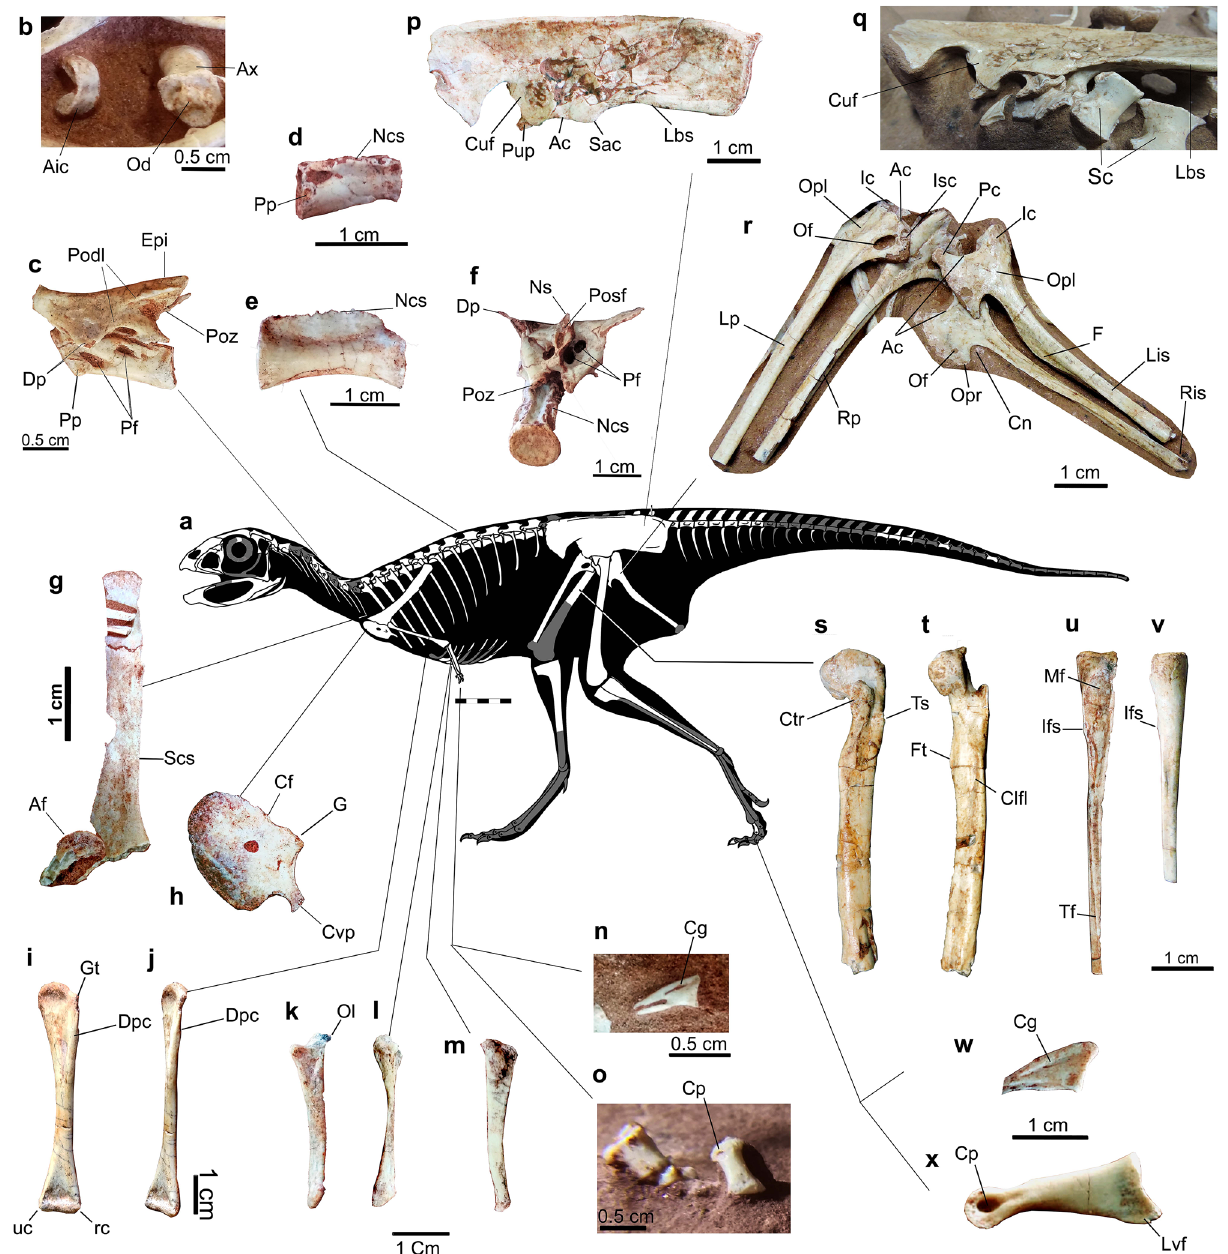
Figure 5. Interpretative line drawing of Berthasaura leopoldinae gen. et sp. nov . , holotype (MN 7821-V), and photographs. ( a ) Line drawing reconstruction; ( b ) Intercetrum and axis in cranioventral views; ( c ) 4th cervical vertebrae in lateral view; ( d ) First trunk centrum in lateral view; ( e ) 8th trunk centrum in lateral view; ( f ) last sacral vertebrae in caudal view; ( g ) right scapula in medial view; ( h ) left coracoid in lateral view; ( i , j ) left humerus in cranial and lateral views, respectively; ( k , l ) left ulna in lateral and cranial views, respectively; ( m ) left radius in cranial view; ( n ) manual ungual in lateral view; ( o ) manual phalanges II (in dorsal view) and III (in lateral view); ( p ) left ilium in lateral view; ( q ) left ilium in ventral view; ( r ) pubes and ischia; ( s , t ) left femur in cranial and medial views, respectively; ( u ) left fibula in medial view; ( v ) right fibula in lateral view; ( w ) pedal ungual in lateral view; ( x ) left pedal phalanx III-1 in lateral view. Abbreviations: Ac, Acetabular margin; Af, Acromion fragment; Aic, Axial intercentrum; Cf, Coracoid foramen; Cg, Colateral vascular groove; Clfl, Fossa for attachment of M. Caudofemoralis longus ; Cn, Caudal notch; Cp, Colateral pit; Ctr, Cranial trochanter; Cuf, Cuppedicus fossa; Cvp, Caudoventral process; Dp, Diapophysis; Dpc, Deltopectoral crest; Epi, Epipophysis; F, Flange; Ft, Fourth trochanter; G, Glenoid; Gt, Greater trochanter; Ic, Iliac contact; Ifs, scar for M. iliofibularis ; Isc, Ischial contact; Lbs, Lateral brevis shelf; Lis, Left ischium; Lp, Left pubis; Lvf, Lateroventral flange; Mf, Medial fossa; Clfl, Fossa for M. caudofemoralis longus ; Ncs, Neurocentral suture; Ns, Neural spine; Od, Odontoid process; Ax, Axial centrum; Of, Obturator foramen; Ol, Oleacron; Opl, Obturator plate; Opr, Obturator process; Pc, Pubic contact; Pf, Pneumatic foramina; Podl, Postzygodiapophyseal lamina; Posf, Post spinal fossa; Poz, Postzygapophysis; Pp, Parapophysis; Pup, Pubic peduncle; Rc, Radial condyle; Ris, Right ischium; Rp, Right pubis; Sac, Supraacetabular crest; Scs, Scapular shaft; Ts, Trochanteric shelf; Uc, Ulnar condyle. Line drawing by